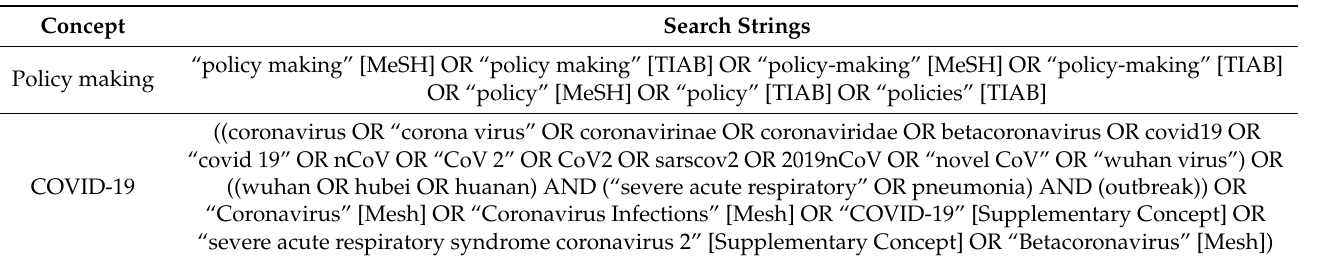
Table 1. Example PubMed search